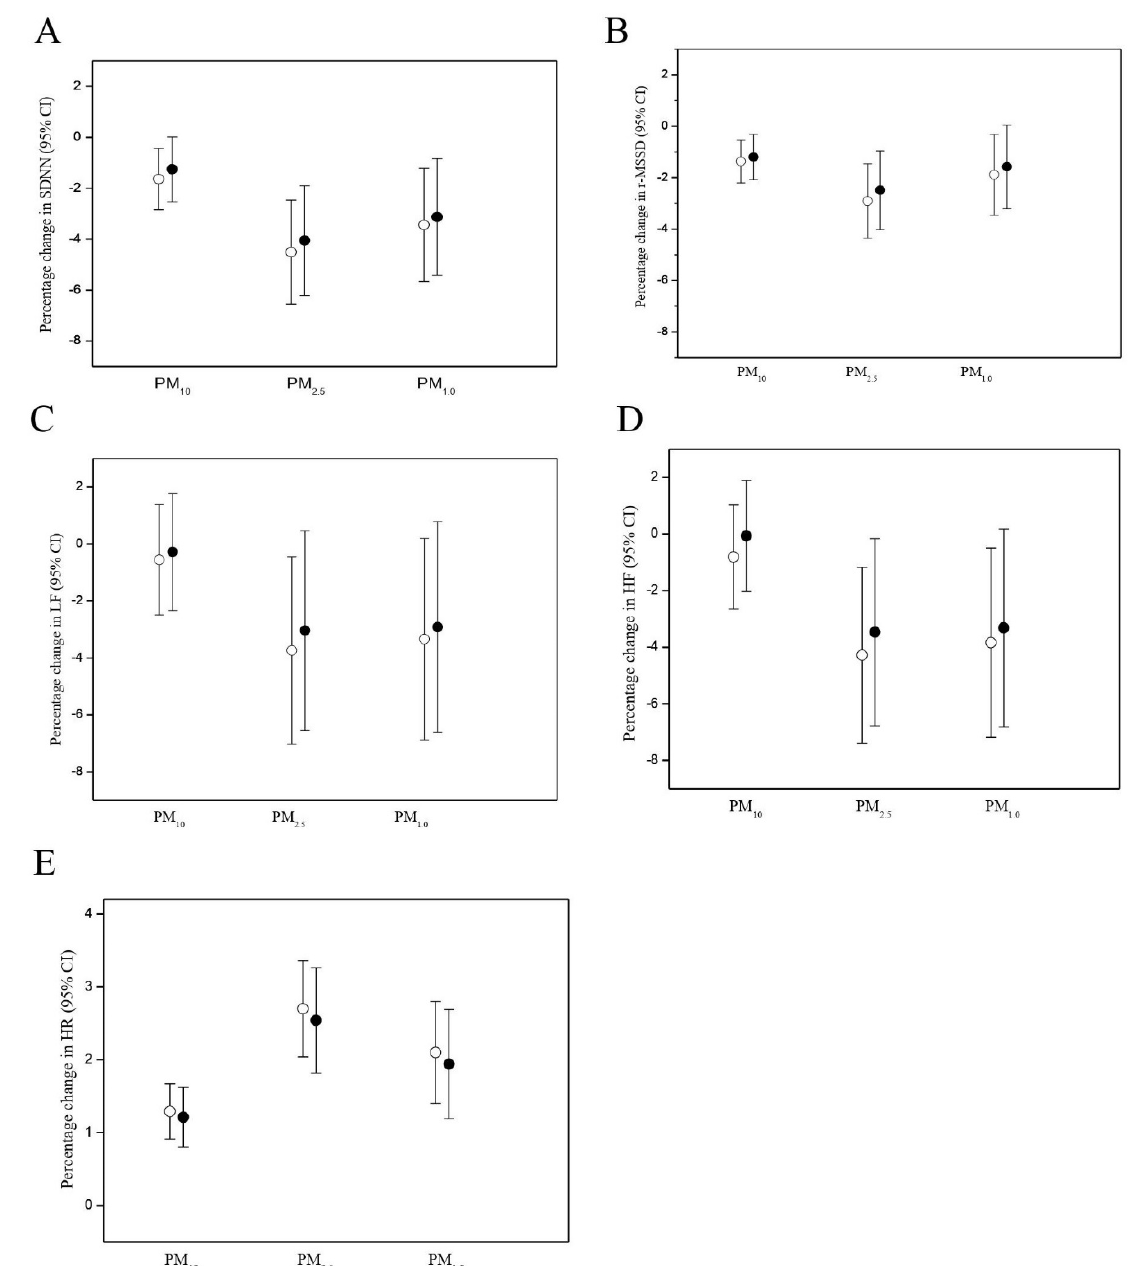
Figure 3. Comparisons of effects of 1-h moving average PM exposure on heart rate variability (HRV) and heart rate (HR) between 26 smokers (solid squares) and 28 non-smokers (open squares) as estimated using the linear mixed effects models. ( A ) Effects of 1-h moving average PM exposure on SDNN with and without cigarette smoking, ( B ) Effects of 1-h moving average PM exposure on r-MSDD with and without cigarette smoking, ( C ) Effects of 1-h moving average PM exposure on LF with and without cigarette smoking, ( D ) Effects of 1-h moving average PM exposure on HF with and without cigarette smoking, ( E ) Effects of 1-h moving average PM exposure on HR with and without cigarette smoking. Models were adjusted for age, BMI, years as a cook, and ambient temperature.